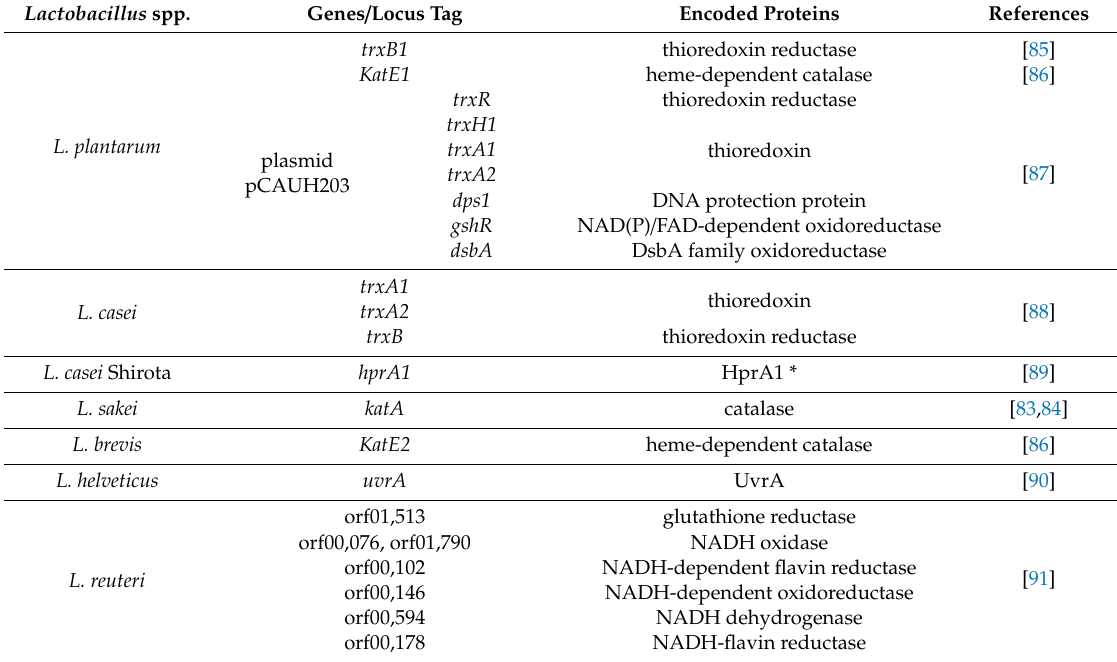
Table 2. Common oxidative stress resistance genes and proteins found in Lactobacillus spp. Lactobacillus